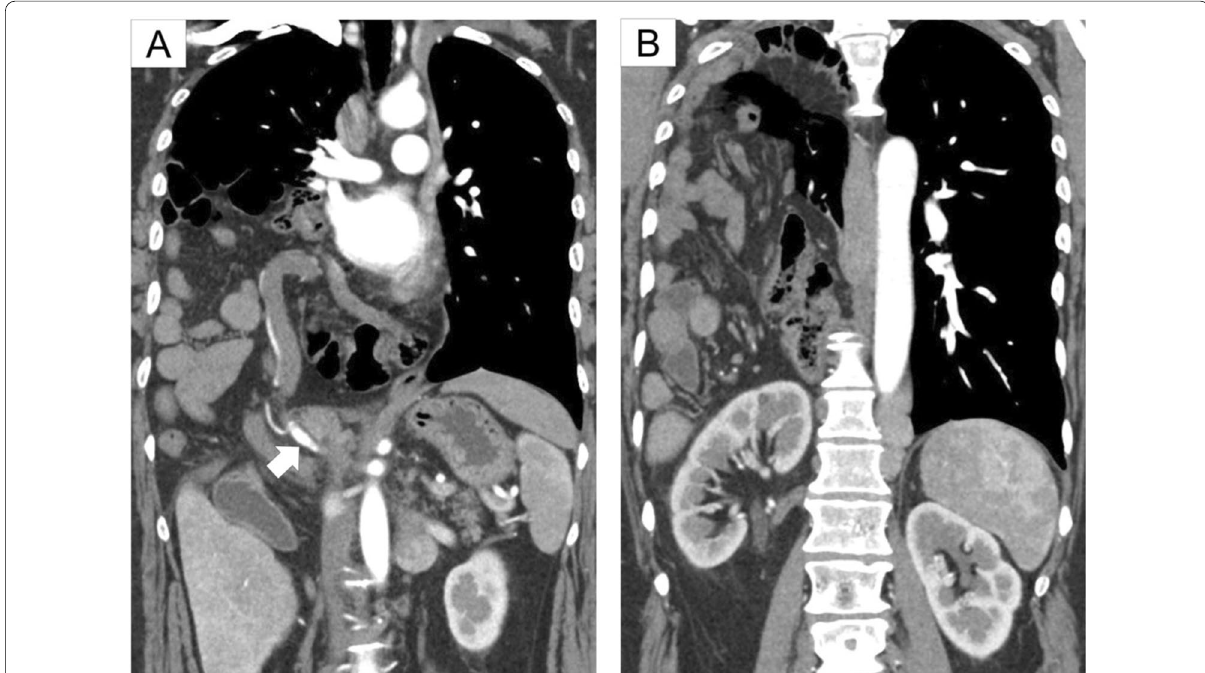
Fig. 2 Coronal views of preoperative contrast medium-enhanced thoracoabdominal computed tomographic scans. a Small intestine, the colon, and the main trunk of the superior mesenteric artery (white arrow) had herniated through the diaphragmatic defect into the right thoracic cavity. b Right kidney was detached from the retroperitoneum and had also herniated into the right thoracic